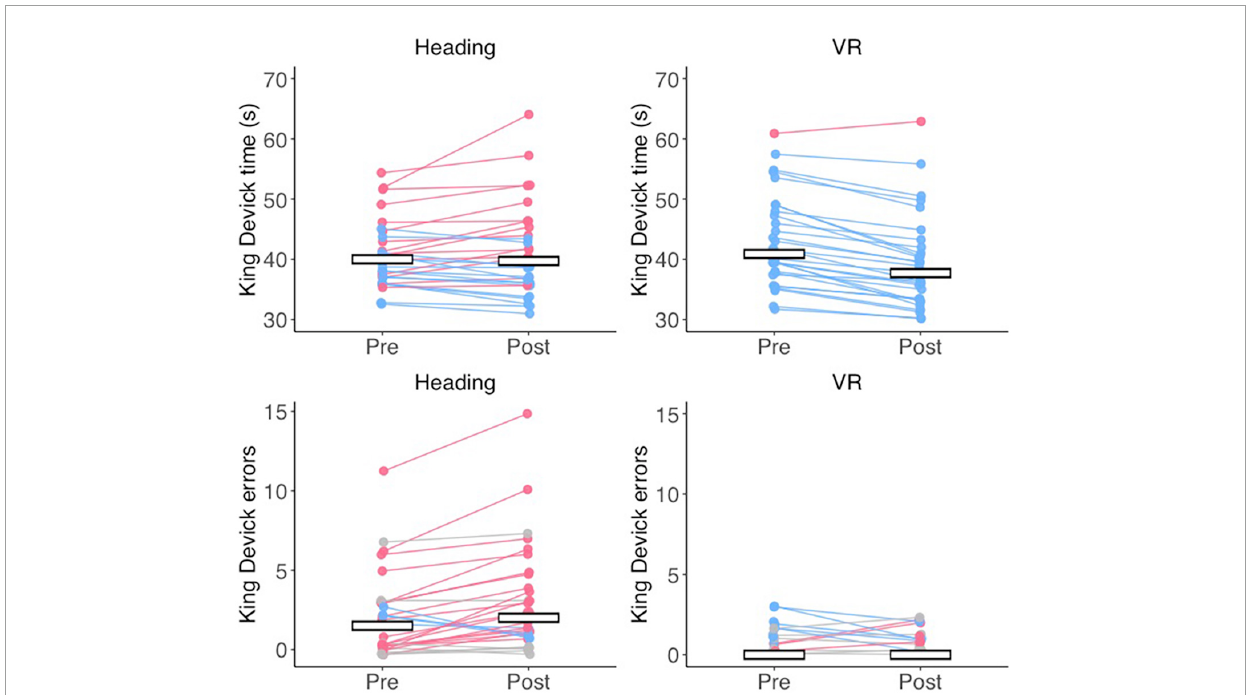
FIGURE2 Cognitive impairments after an acute bout of soccer heading. Jitter plots displaying the mean time (in seconds) taken to complete the King Devick (top row) and the number of errors (bottom row) at pre- and post-test for the Heading and VR groups. Lines connect the pre- and post-test times for a single participant, with red data reflecting slower times/more errors at post-test, blue data reflecting faster times/less errors at post-test, and gray data refleting no change. Crossbars indicate the group mean for King-Devick time, and the group median for King-Devick errors.